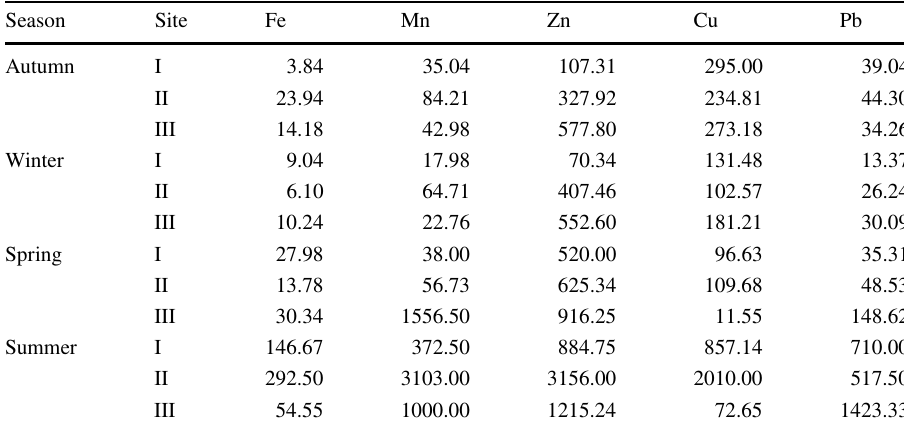
factor (L/Kg) of different heavy metals in liver of Nile Tilapia